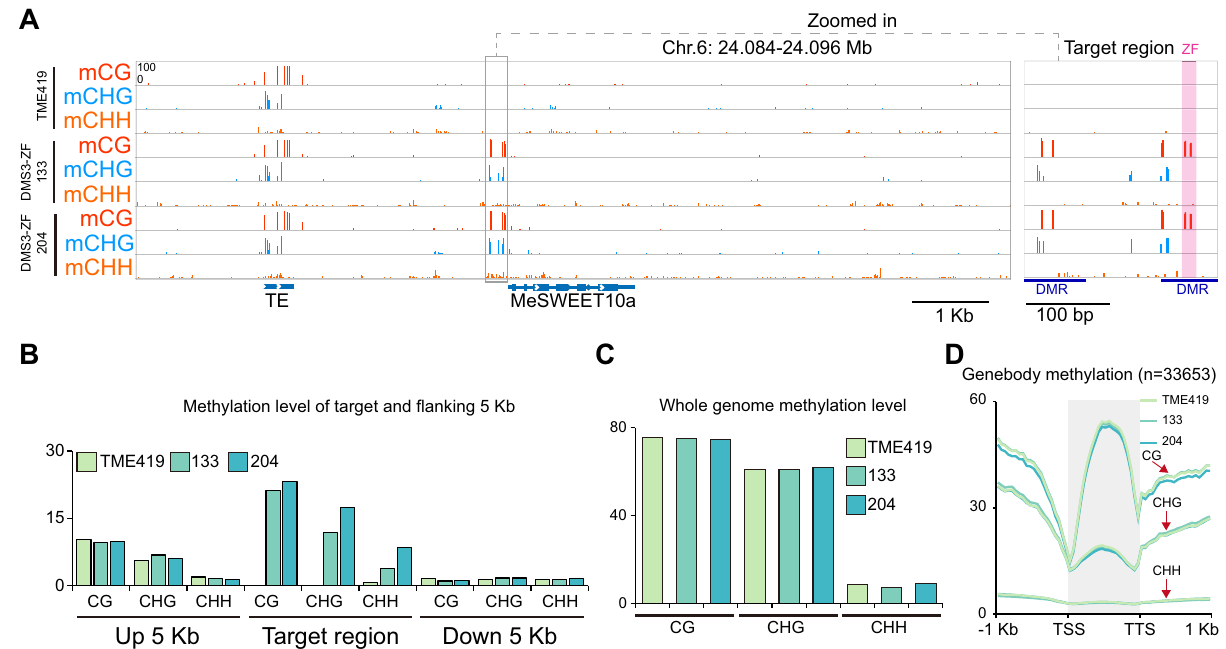
Fig. 3 | Targeted methylation at MeSWEET10a shows high speci fi city. A Distribution of CG, CHG, and CHH methylation over the targeted and fl anking 5kb regions of the MeSWEET10a promoter in wild-type TME419 and two inde- pendent DMS3-ZF lines (transgenic lines 133 and 204). Gray box indicates the tar- geted region within the MeSWEET10a promoter. ZF binding site is shaded within the pink box. Two detected hypermethylated differentially methylated regions (DMR) are also indicated. B Summary of CG, CHG, and CHH methylation level of